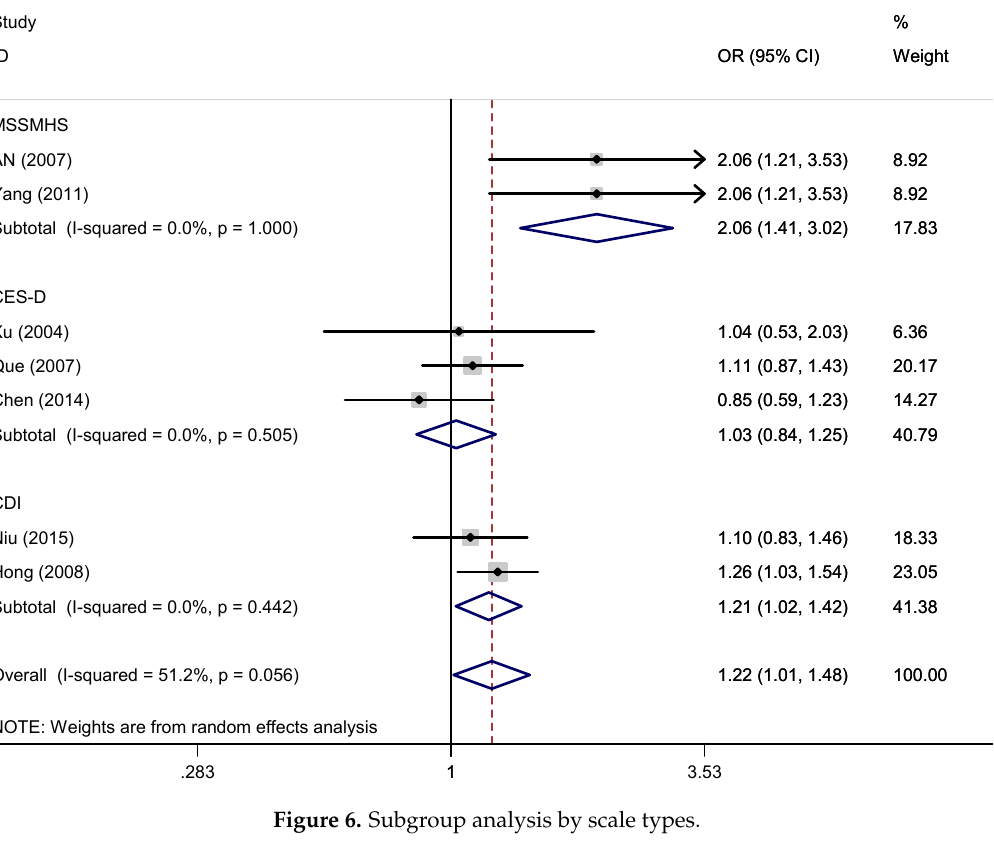
Figure 6. Subgroup analysis by scale types.